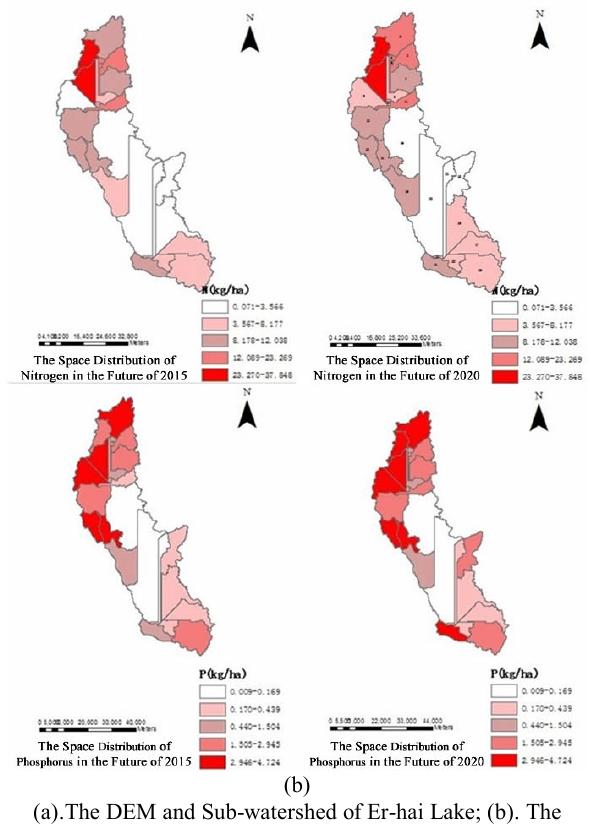
Figure 6. The SWAT-Based Hydrological Analysis and The Distribution of Water Quality in